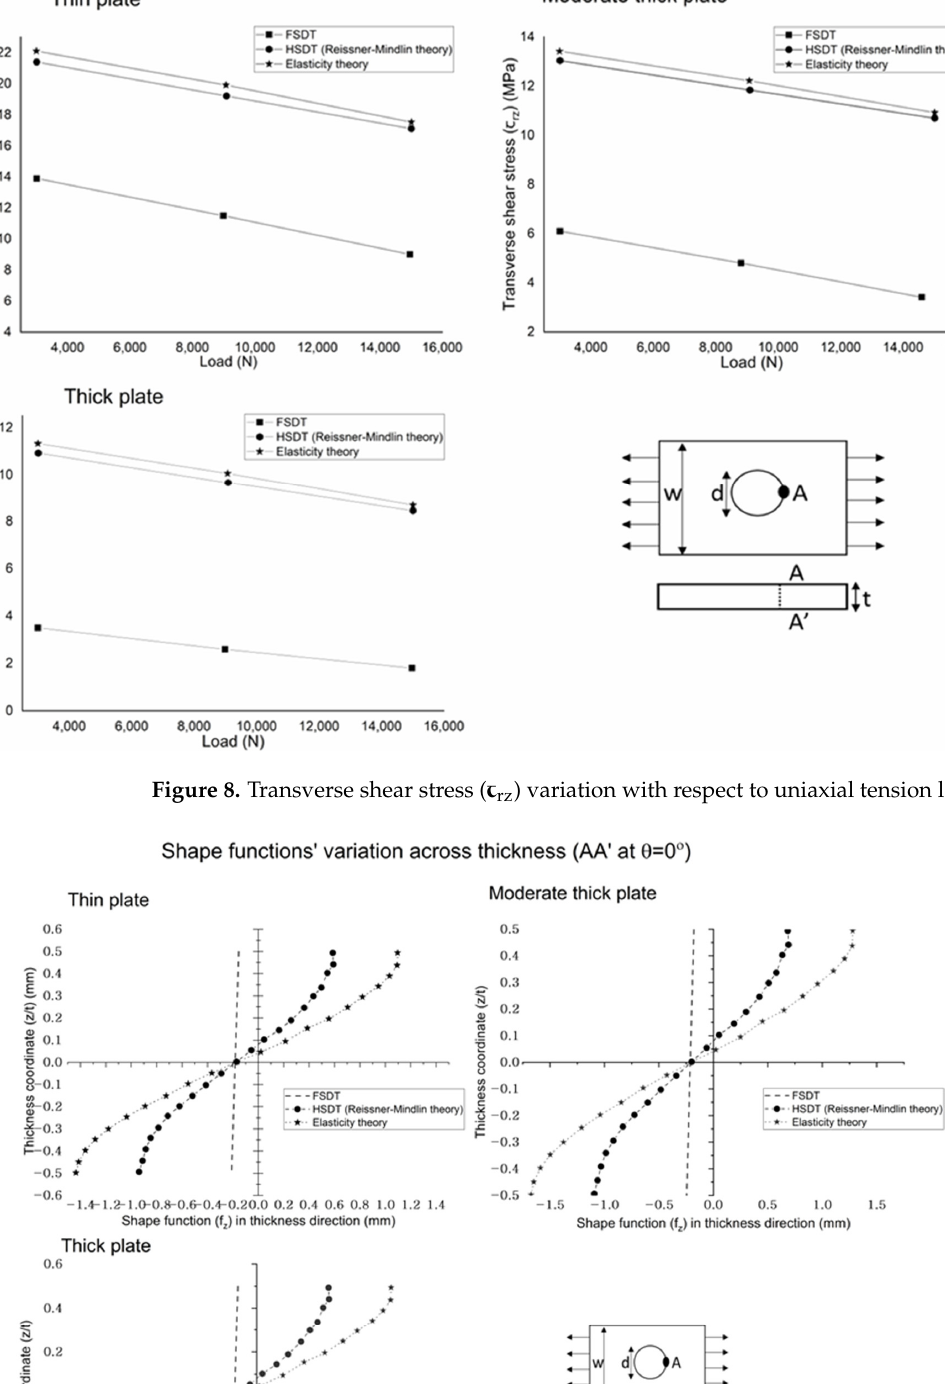
Figure 9. Shape function (f z ) variation across the thickness of braided polymer plate.